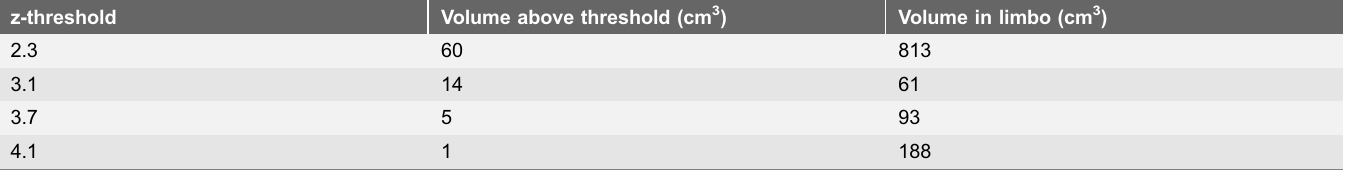
The amount of area that is labeled in limbo for different z-thresholds applied to the dataset of Forstmann et al.,